Question: Give a one-sentence summary of this figure.
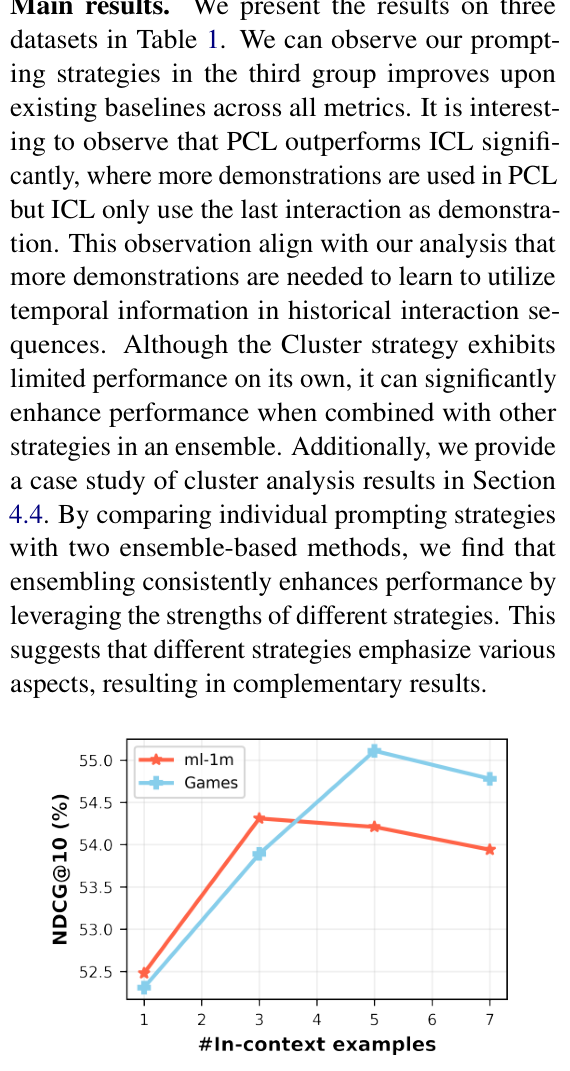
Answer: Impact of #in-context examples in PCL. Sev- eral more examples can improve performance.